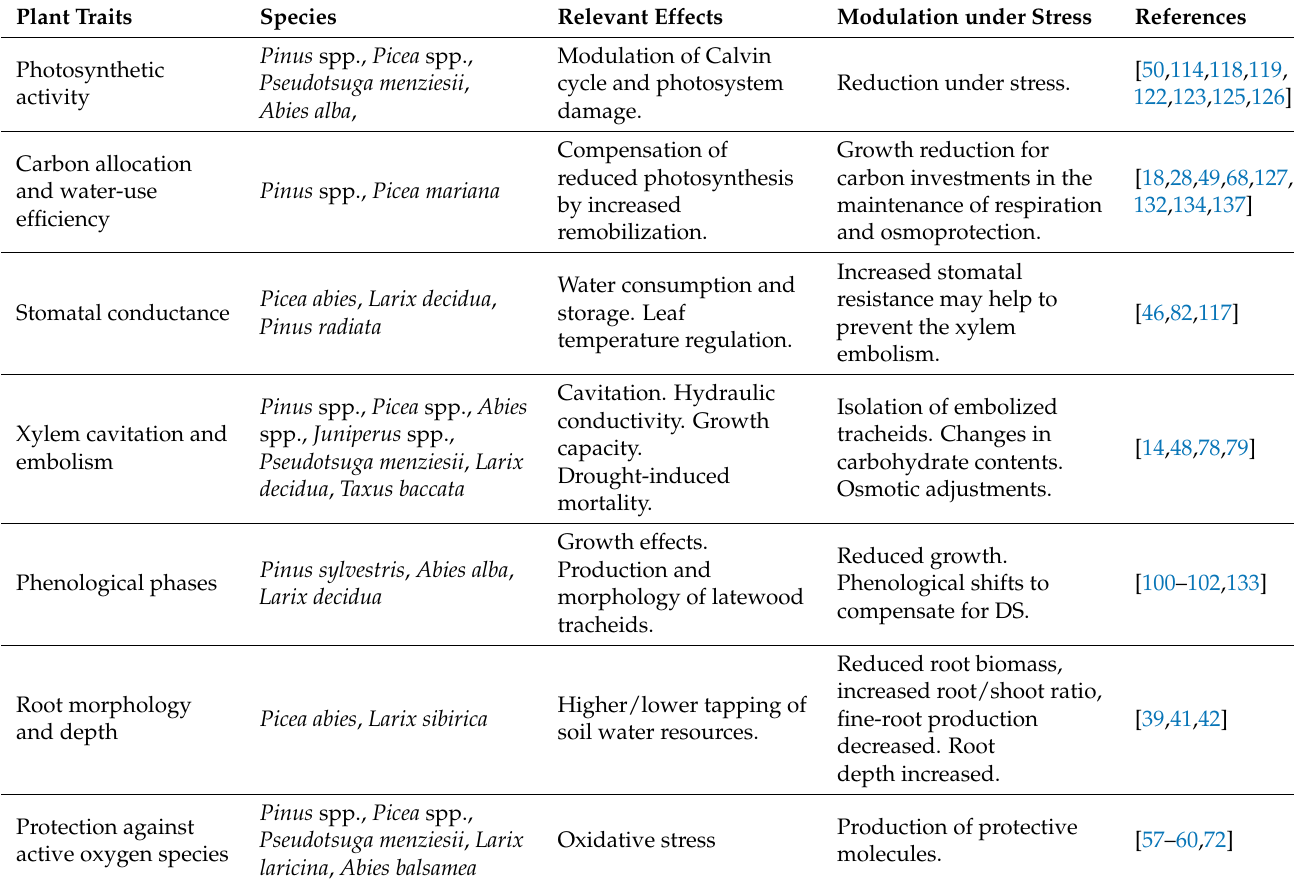
Table 1. Physiological traits relevant for drought